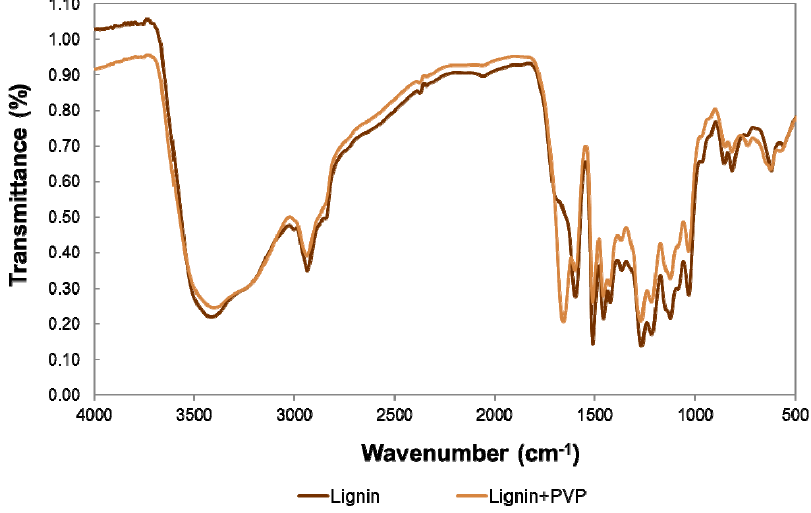
Figure 2. FTIR spectra of the lignin and lignin + PVP samples.